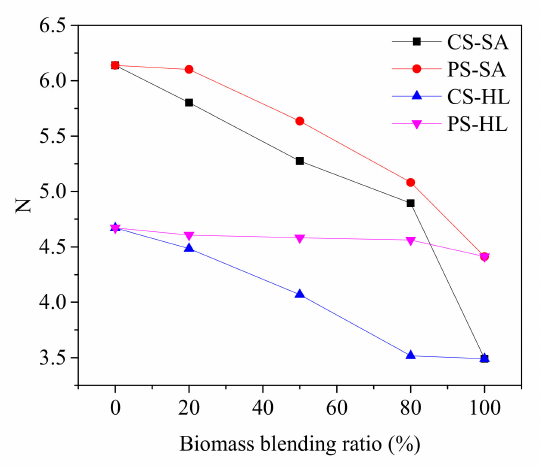
Figure 4. The stacking layer number of various char